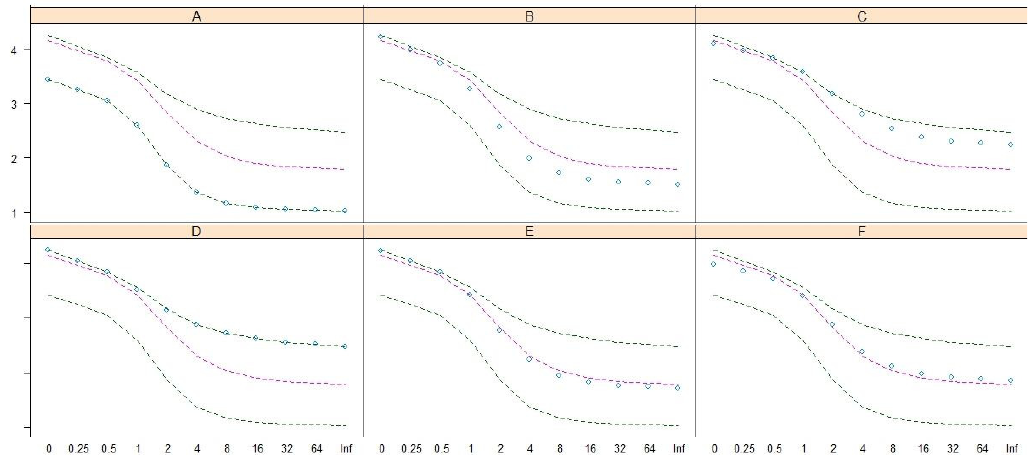
Figure 5. The Renyi diversity profiles show the biodiversity structure of patterns ( A – F ). The y -axis and x -axis are the values and scales of Renyi diversity, respectively.